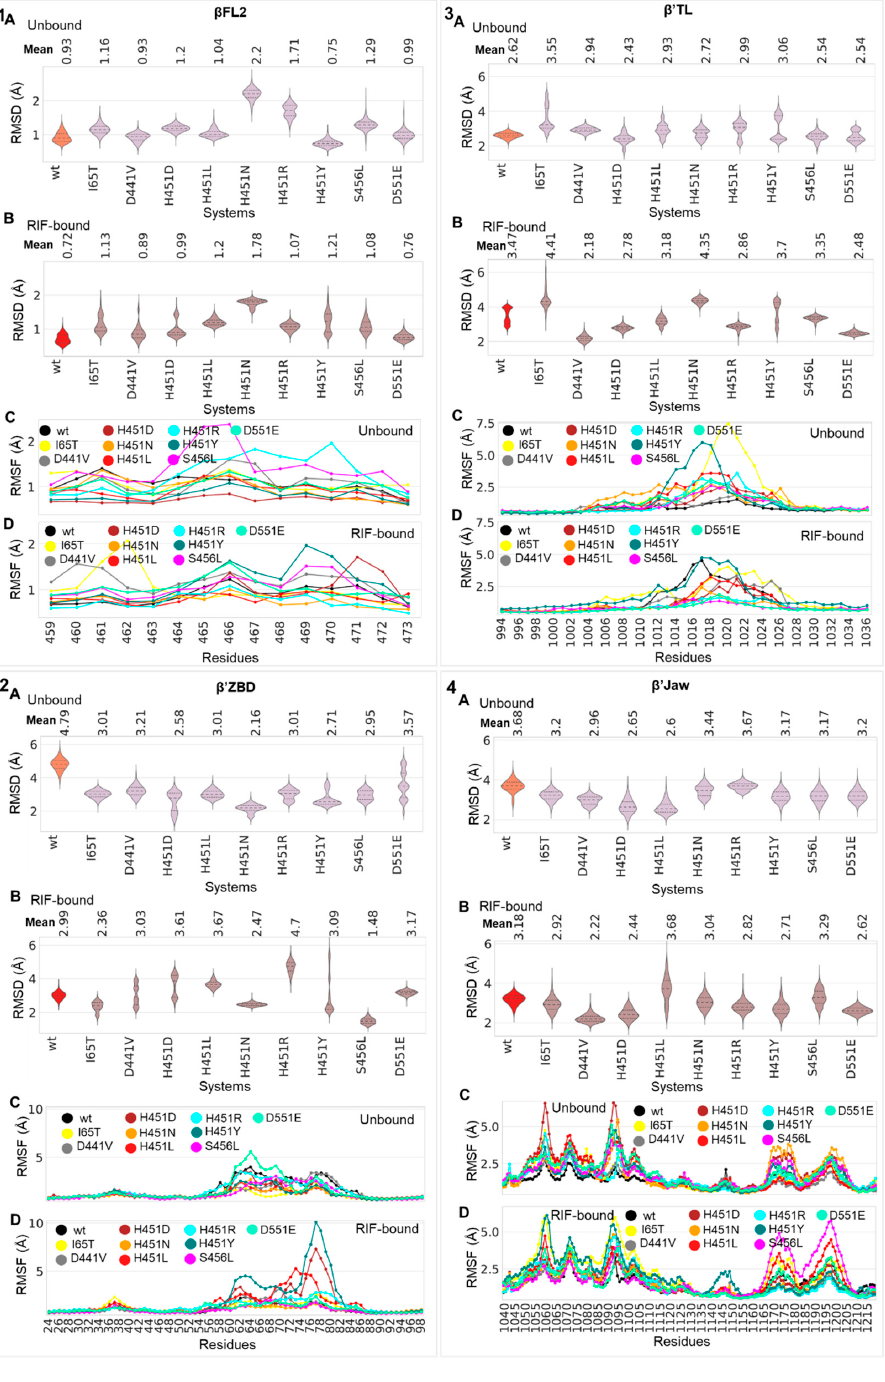
Figure 3. Structural analysis of the Mtb -RNAP functional domains; ( 1 ) β fork loop2 ( β FL2), ( 2 ) β ’zinc-binding domain ( β ’ZBD), ( 3 ) β ’trigger loop ( β ’TL) and ( 4 ) β ’jaw in wt and mt systems. C α -RMSD (with reference to their initial structures) distribution violin plots are shown for the ( A ) unbound and ( B ) RIF-bound wt s (unbound, orange; RIF-bound, red) and mt s (unbound, pink; RIF-bound, brown). The mean C α -RMSD values are indicated above the plots while the dotted lines on the violins represent the 25th, 50th and 75th quartiles. The line plots represent the captured C α -RMSF for ( C ) unbound and ( D ) bound wt and mt Mtb -RNAP domains.